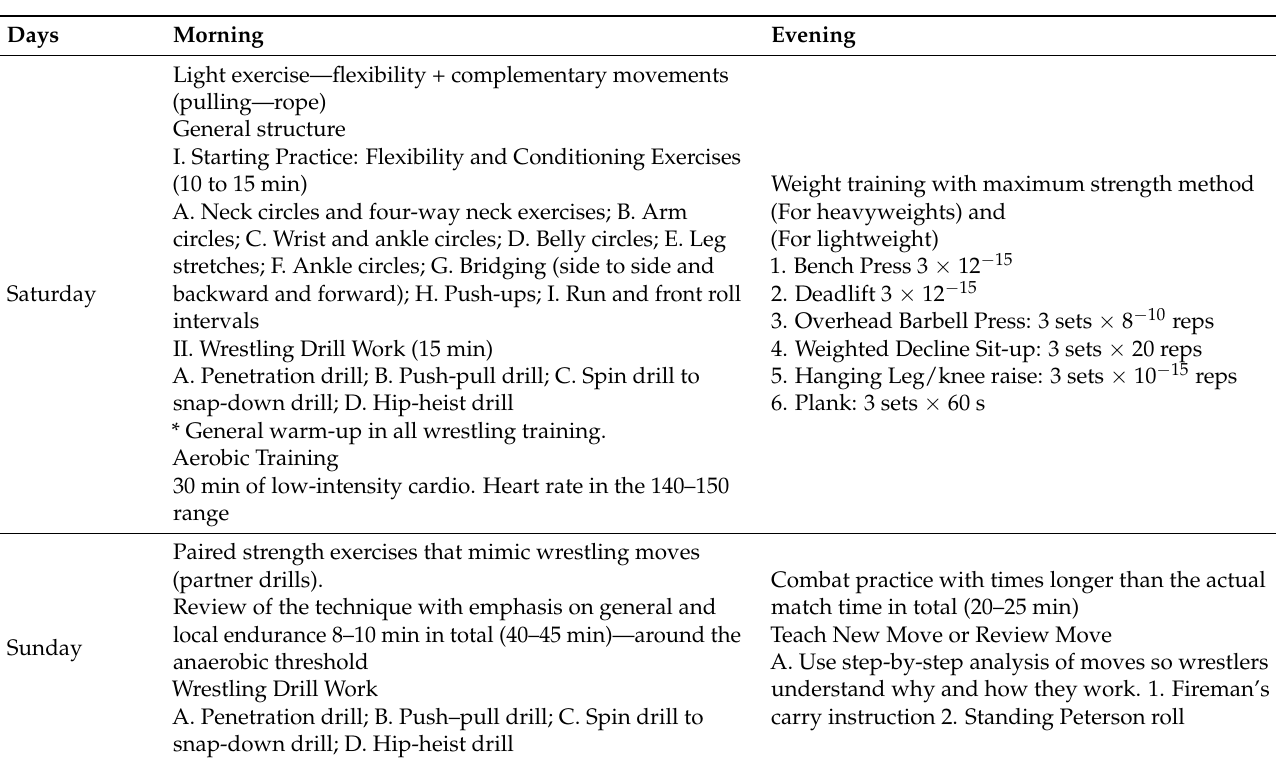
Table 2. Design of a microcycle in the pre of the preparation